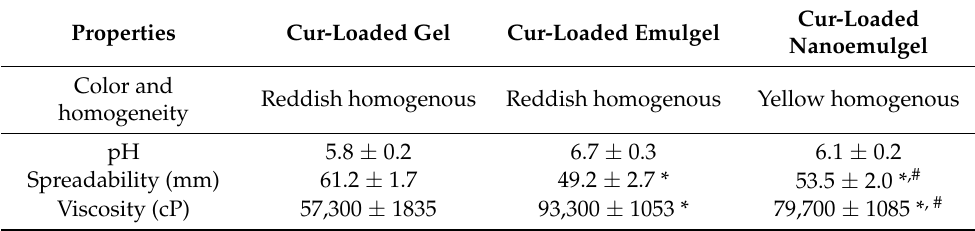
Table 2. Physical characterization of Cur-loaded